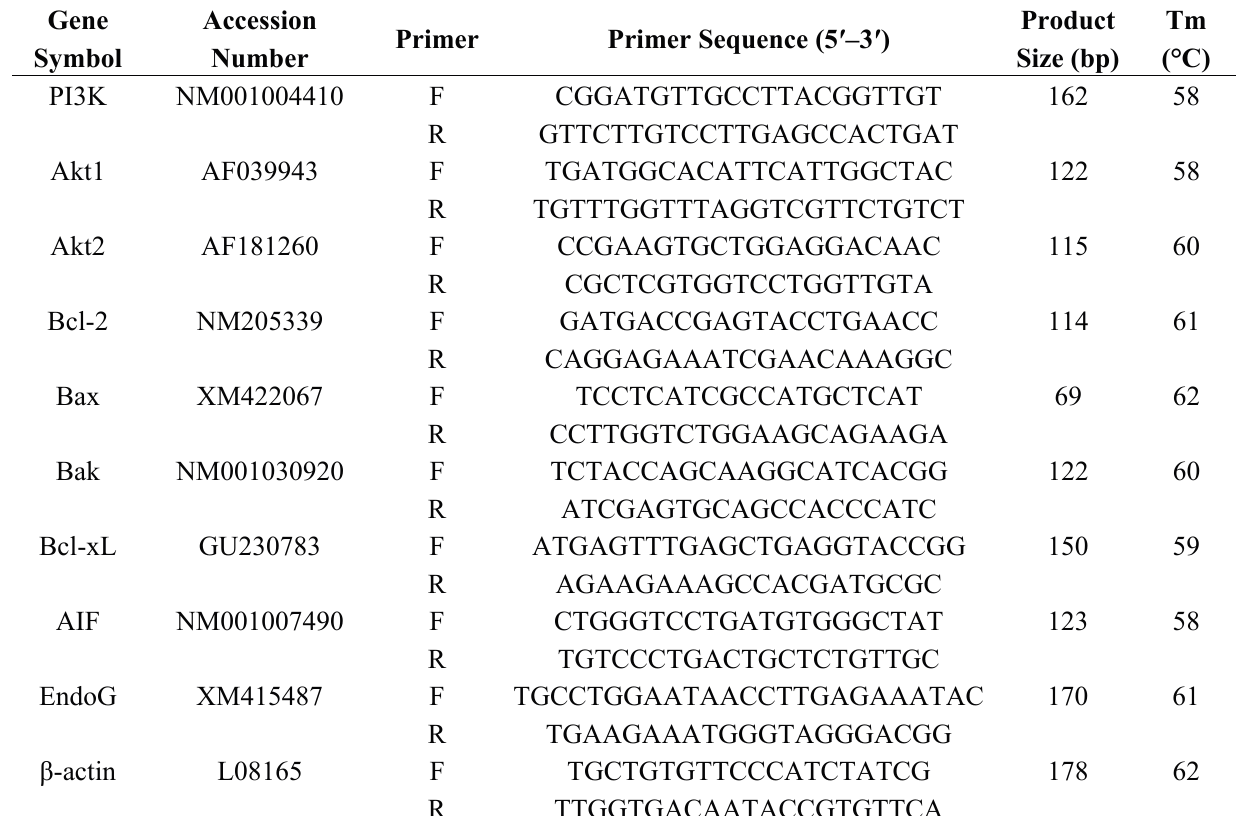
Table 1. A list of primers in qRT-PCR analysis of mRNA expression of the apoptotic